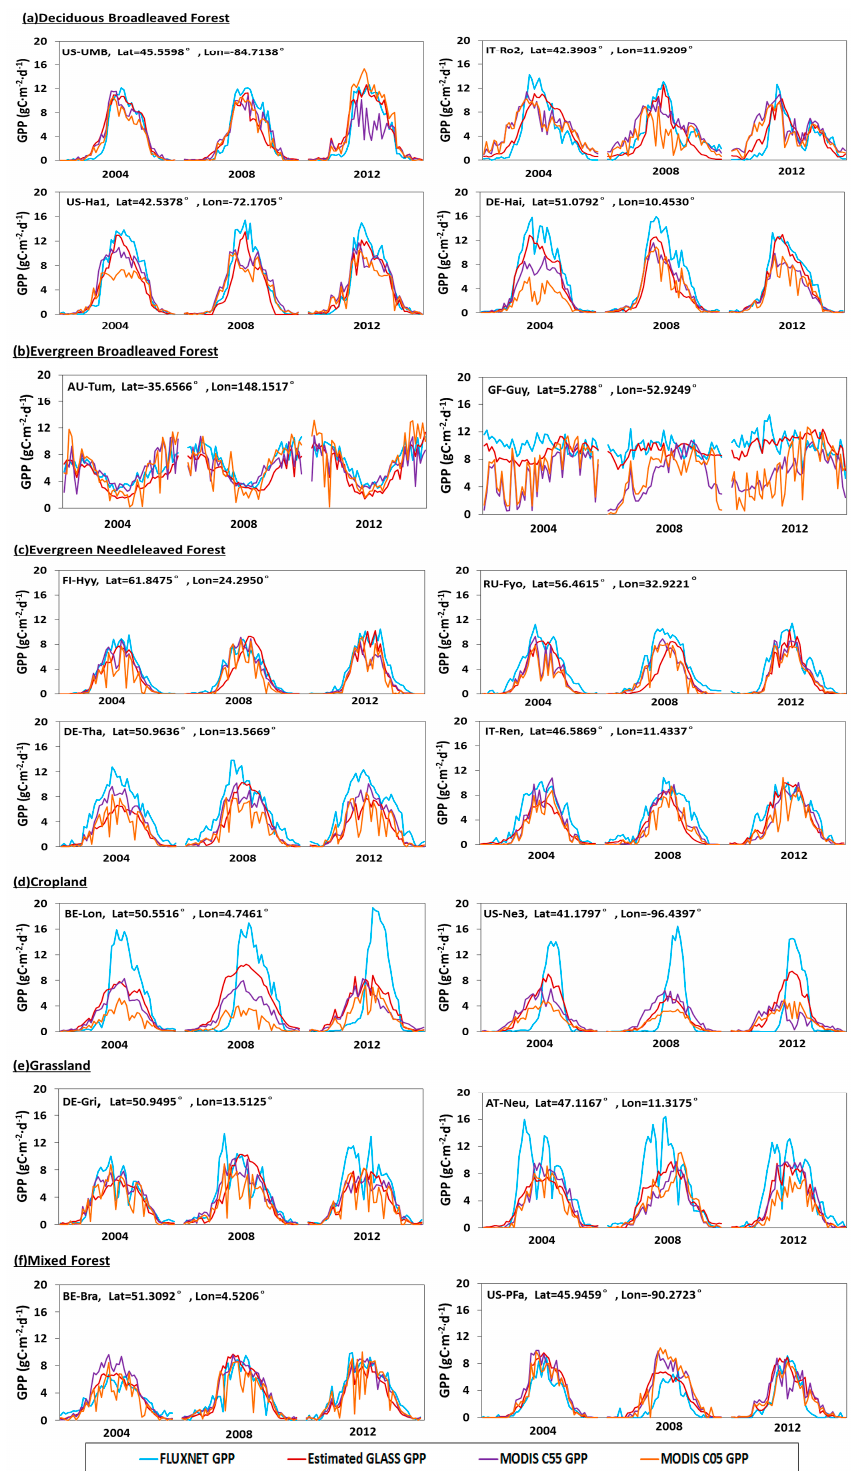
Figure 8. Seasonal variation in the estimated GLASS GPP, FLUXNET GPP, MOD17 C05 GPP and MOD17 C55 GPP for several sites with different vegetation types.